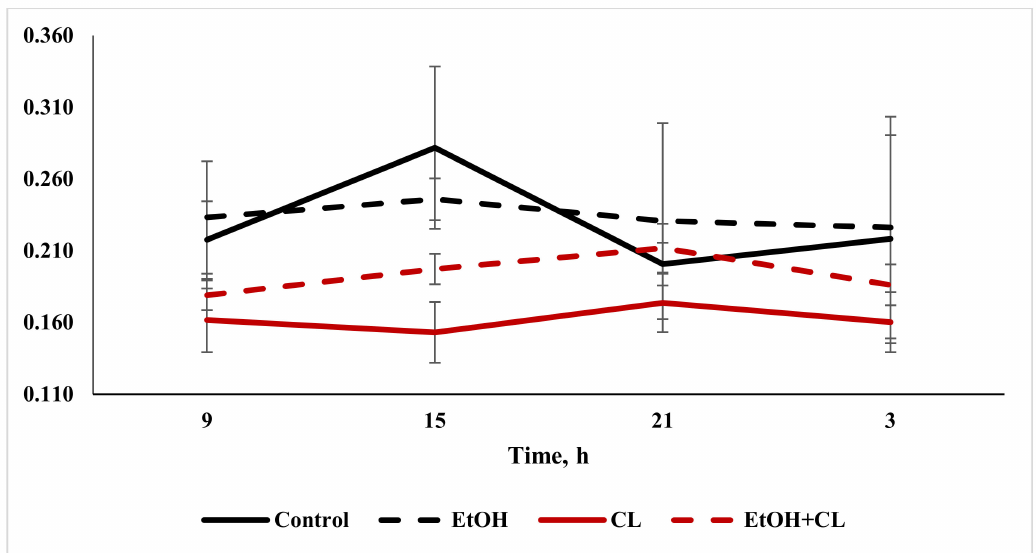
Figure 6. Daily dynamics of NCR in hepatocytes of